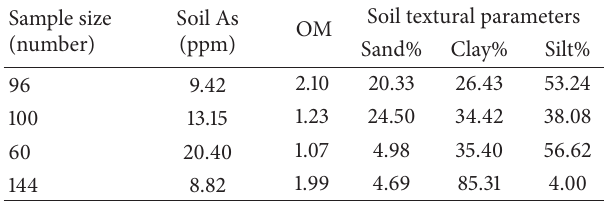
Table 2: Percent distribution of As concentration in water and soil. Table 3: Soil As and textural parameters of surface soil under different command